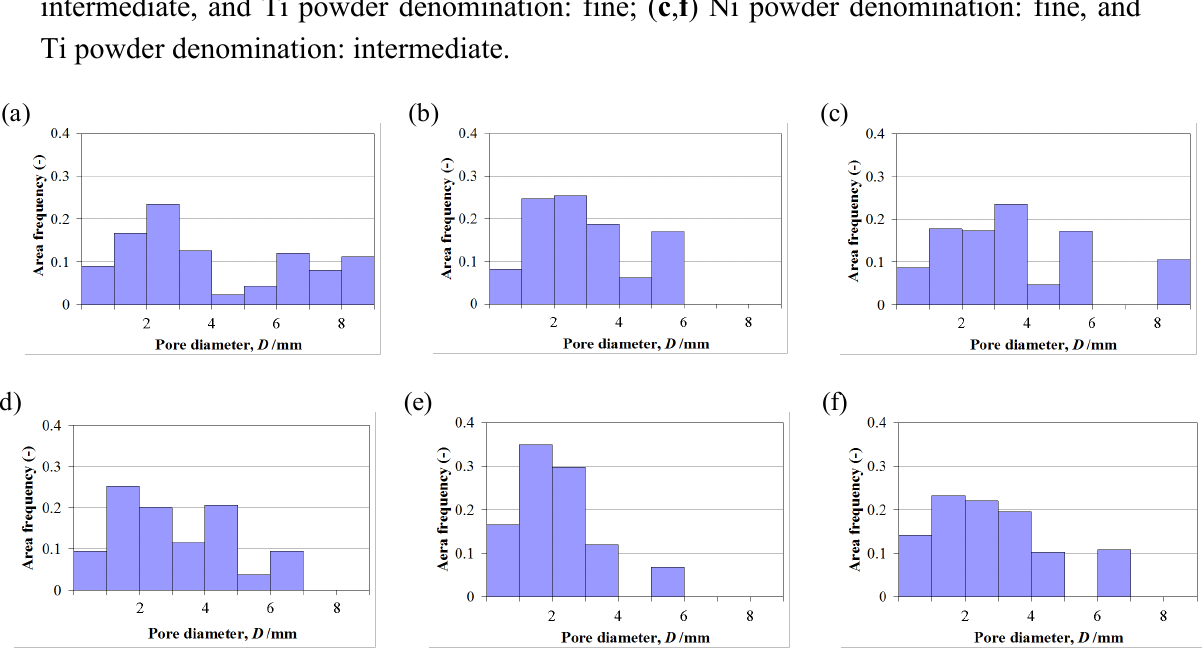
powder admixed with 2